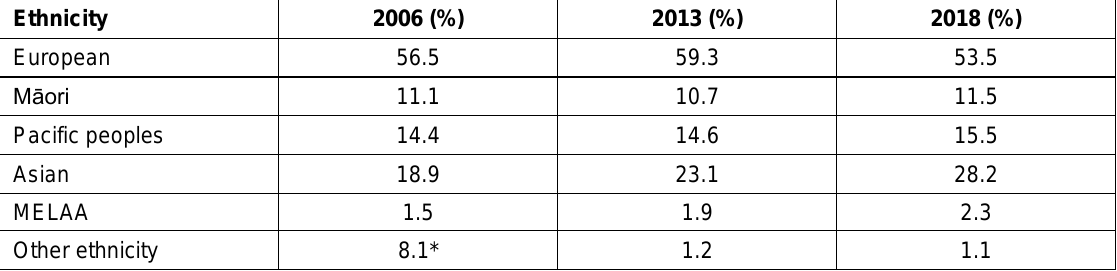
Table 1: Ethnicity of Auckland population – 2006, 2013 and 2018 Census data Ethnicity 2006 (%) 2013 (%) 2018 (%) European 56.5